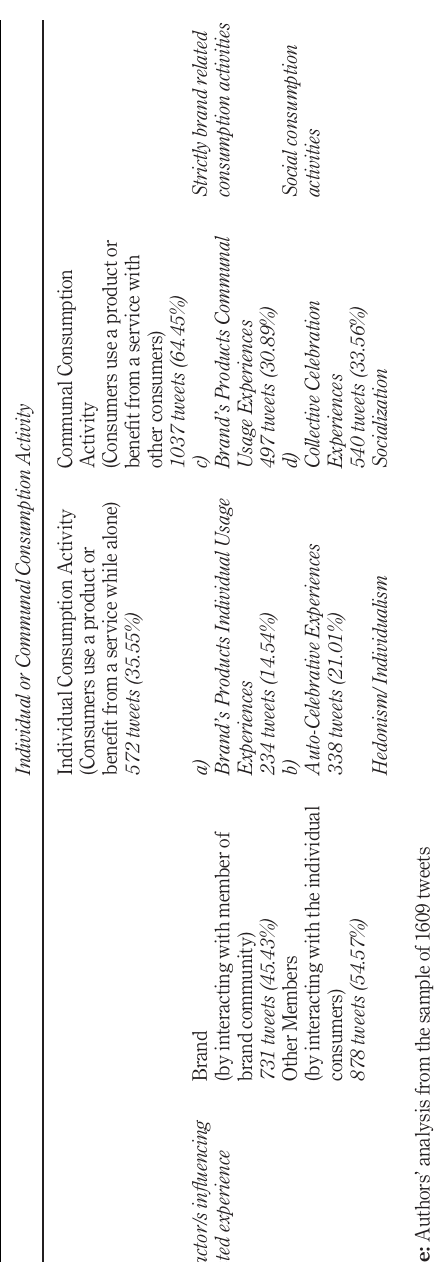
Table IV. The types of co- created